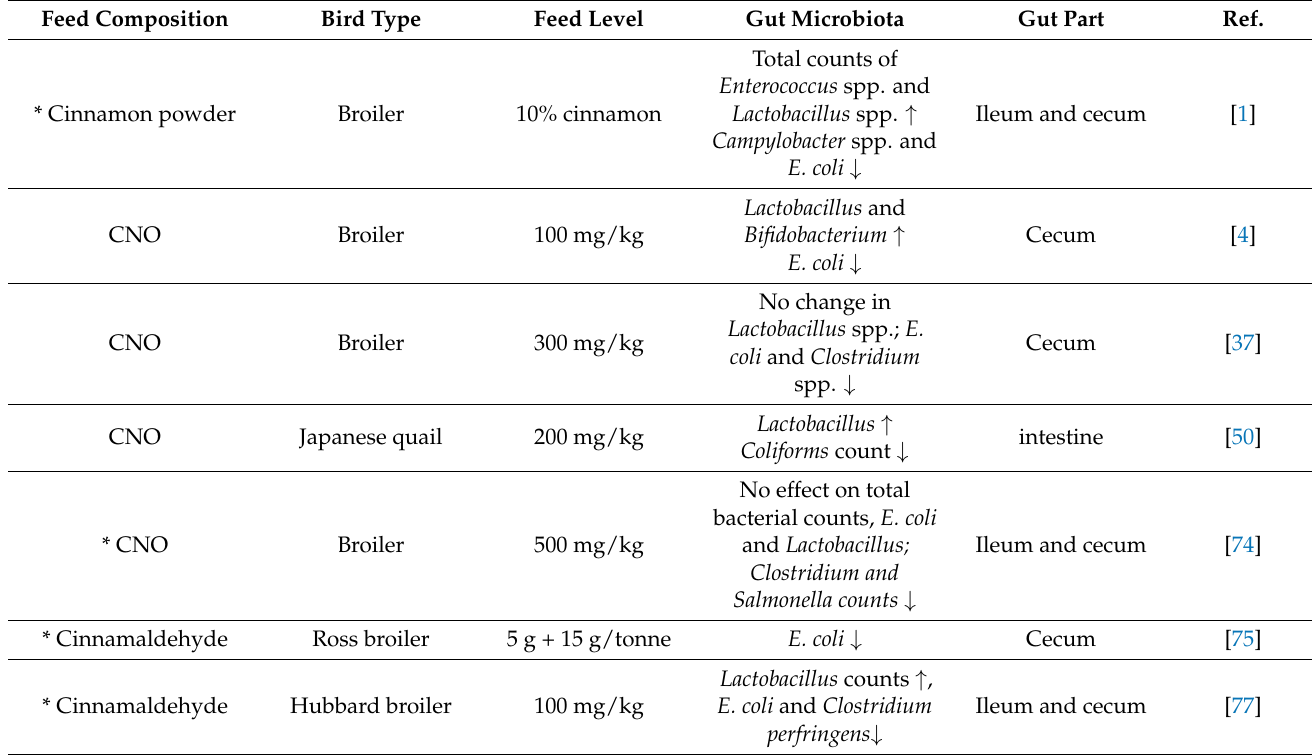
Table 1. Effect of cinnamon on gut microbiota of poultry